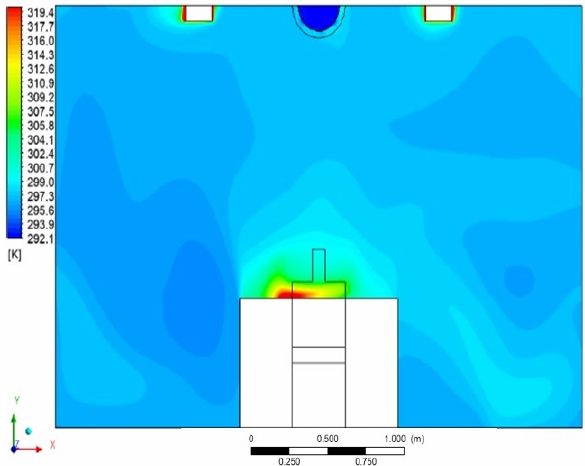
Figure 30. The temperature distribution of the X = 2 m section.